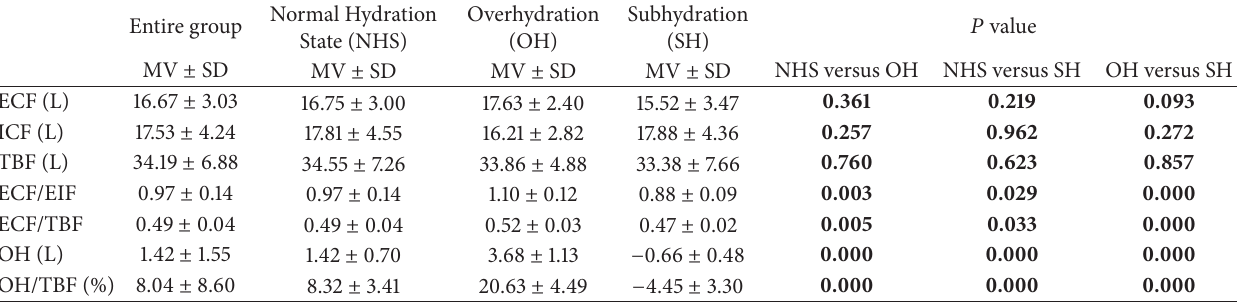
Table 2: Hydric status for the entire population and the hydric state-related groups.